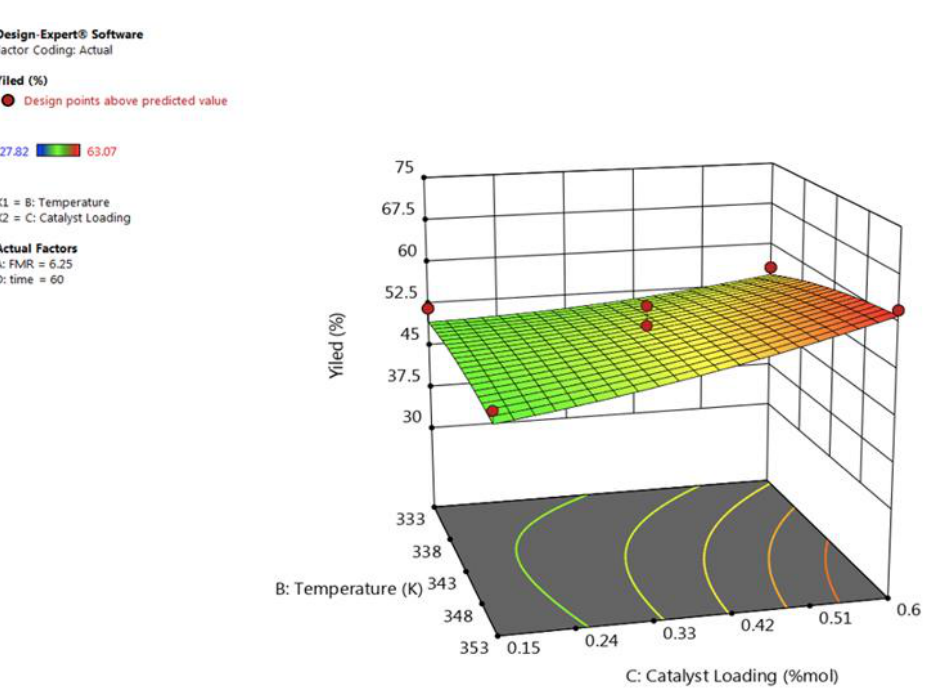
Figure 7. The effect of reaction temperature on the yield of 1,2-epoxy-5-hexene.